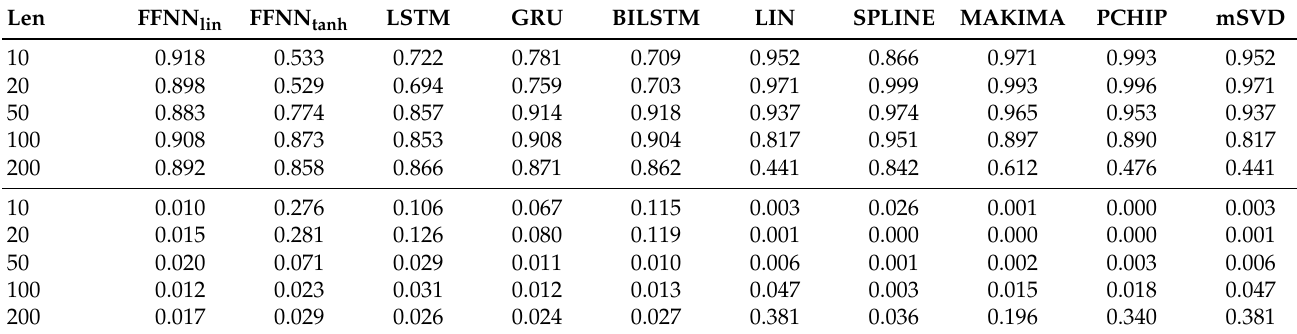
Table A11. Correlation between RMSE and monotonicity of input sequence.